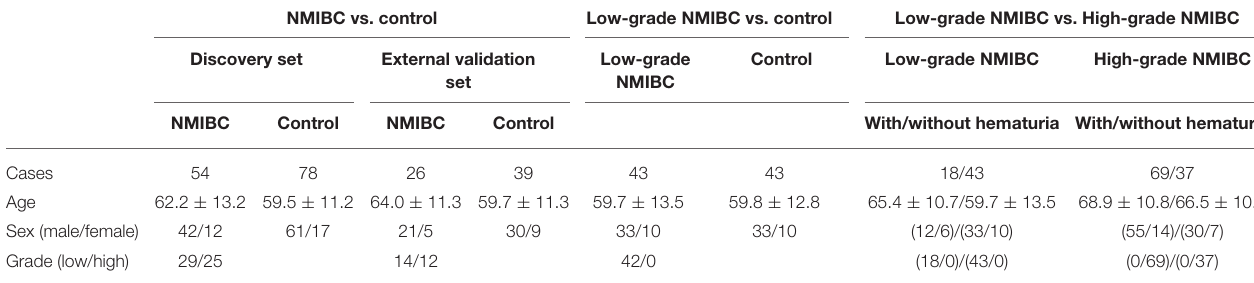
TABLE 1 | Clinical information for the subjects enrolled in exploration for early detection of NMIBC. NMIBC vs.